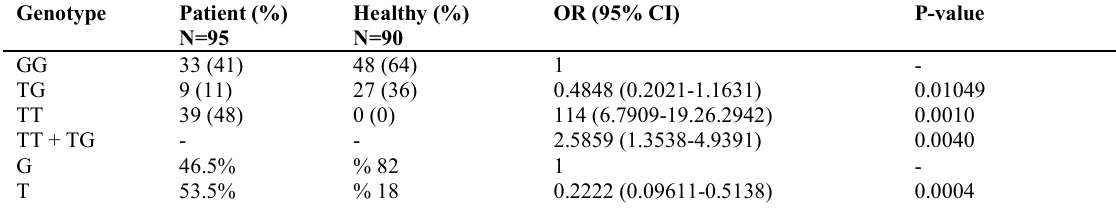
Table 2. Genotypic and allelic frequency of rs13181 gene ERCC2 Genotype